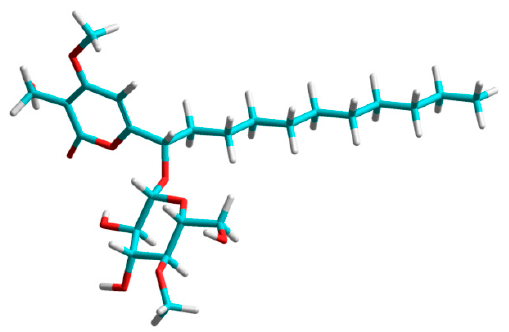
Figure 4. Energy minimized conformation of akanthopyrone A ( 1 ) using HyperChem, pm3 calculation method.